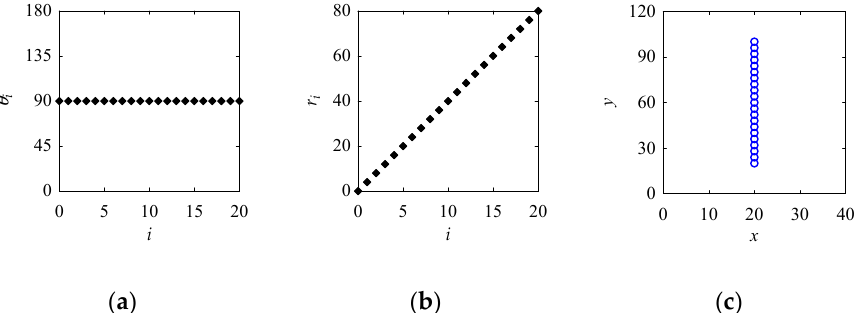
Figure 3. Settings for a vertical straight line using the PCA. ( a ) Input1: θ i ; ( b ) Input2: r i ; ( c ) Output: Point cloud.